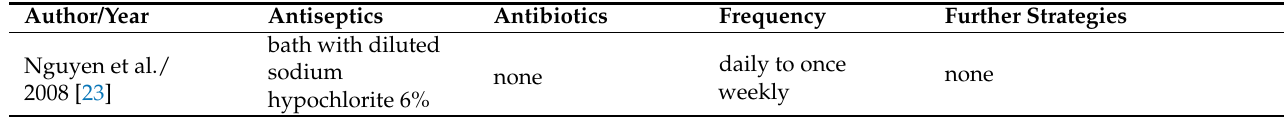
Table 2. Antiseptic and antibiotic regimen in CTCL